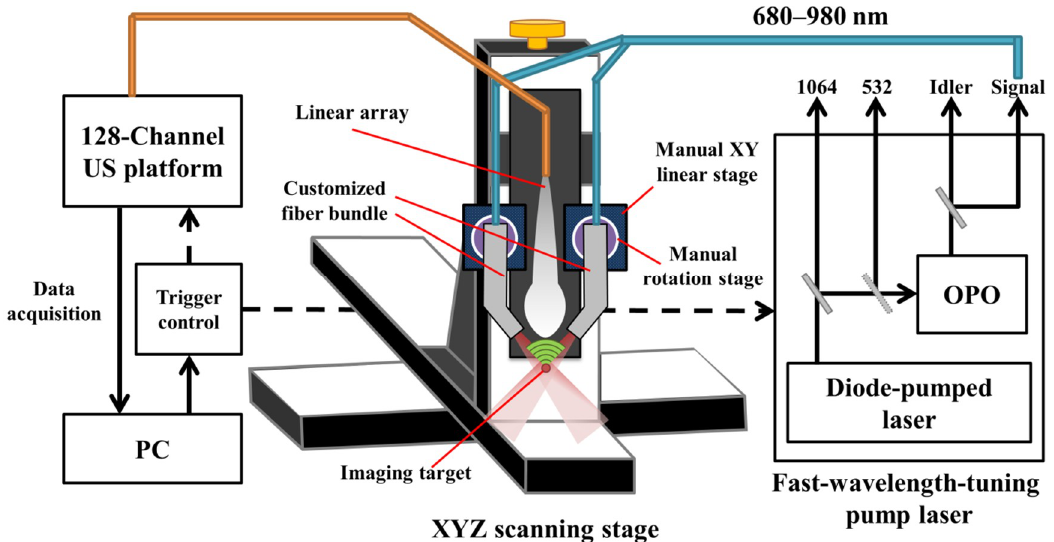
Figure 1. The handheld, real-time photoacoustic (PA) imaging system. One custom-designed optical parametric oscillator (OPO) diode-pumped by a Nd:YAG laser at 532 nm was employed for laser illumination with a fast-wavelength-tuning function for each pulse. The customized fiber bundle was used to deliver the laser light onto the target. Light was evenly distributed into the two arms with a rectangular output size of 16.5 mm × 0.8 mm. A 128-channel research ultrasound (US) platform with a high-frequency array transducer was used for recording the generated PA signal. For proof of simulation results, the PA probe (i.e., fiber bundle with US transducer array) was mounted on the linear and rotation stages to adjust the interval and angle of the two arms. For phantom and in vivo studies (e.g., small animal experiments), the XYZ 3-axis scanning stage with frame holder was used to precisely/automatically image the region of interest (ROI) of the target in either the X or Y direction.